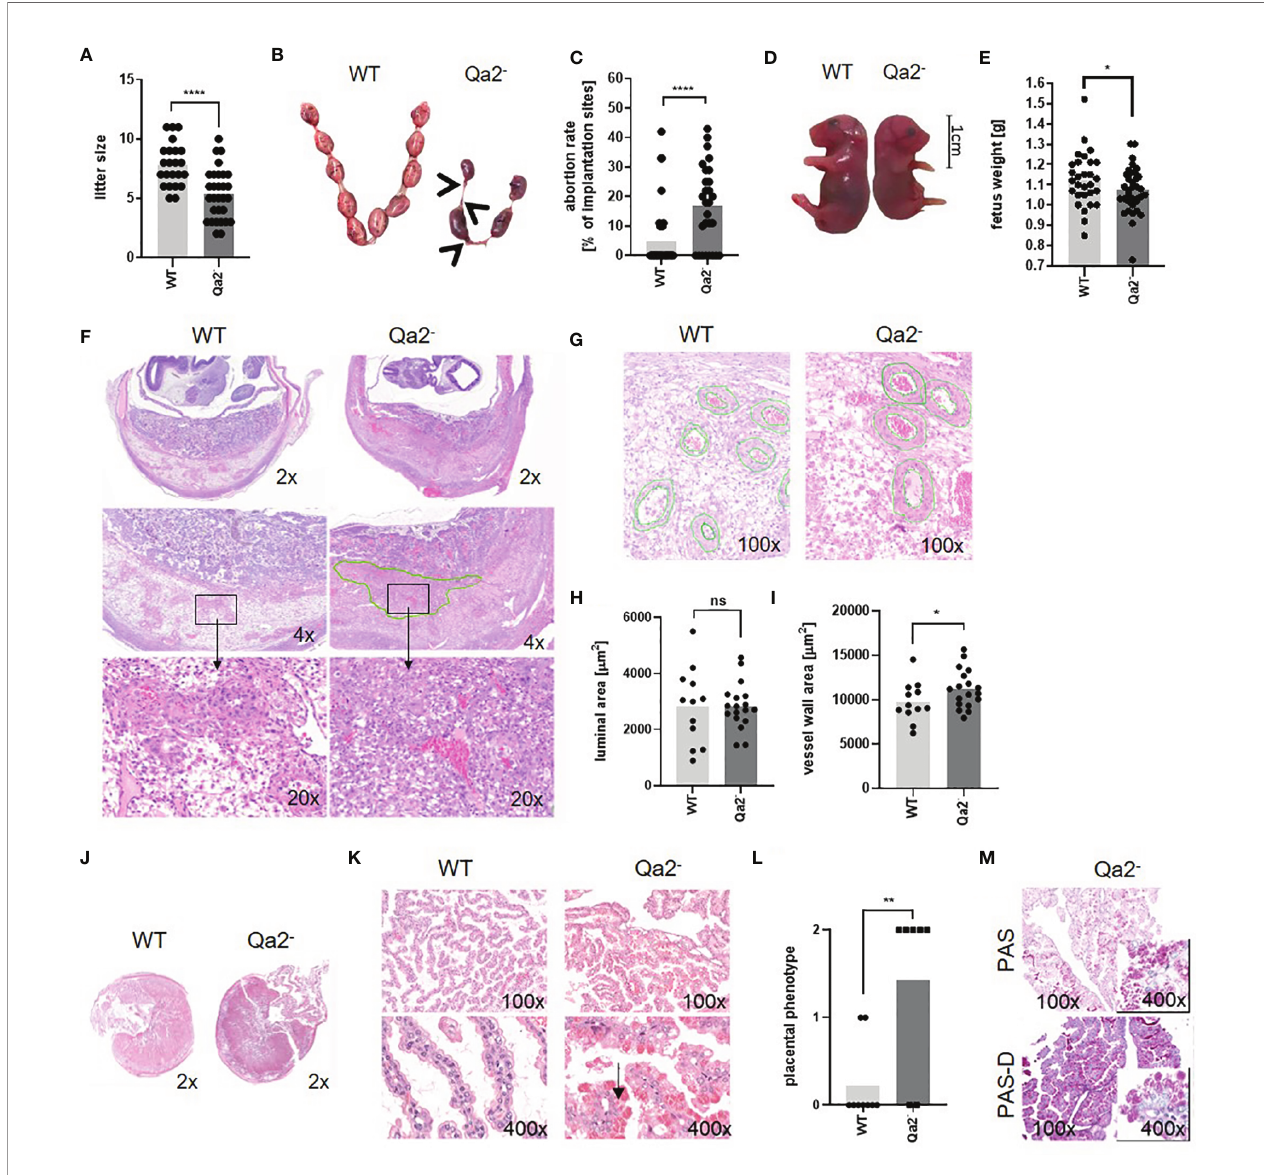
FIGURE 1 | Phenotype of Qa-2 - mice during pregnancy. Wildtype (WT) and Qa-2 de fi cient mice (Qa2 - ) were term-bred and the day when a vaginal plug was detected was de fi ned as day E0.5. Mice delivered spontaneously and litter size was determined (A) or mice were euthanized at E18.5 and uteri containing feto- placental units were removed and inspected (B – E) . Total implantation sides and resorbing units were counted and fetuses were weighed. (A) Litter size of spontaneous delivered WT (n=23) and Qa2 - mice (n=30). (B) Representative uteri containing feto placental units from WT and Qa-2 - mice at gestational day E18.5. Arrows show resorbing units. (C) Abortion rate (percentage of resorbed fetuses per litter) of WT (n=39) and Qa-2 - mice (n=28) at E18.5. (D) Representative WT and Qa-2 - fetuses at E18.5. (E) Weight of WT (n=29) and Qa-2 - fetuses (n=35) at E18.5. (F – I) Mice were euthanized at E10.5, uterine arteries were ligated and spiral arteries were analyzed. (F) Representative images of H&E stained WT and Qa-2 - uteri showing cross-section areas of placenta and decidua in different magni fi cations. The green line shows an area with unorganized trophoblast distribution within the Qa-2 - decidua. (G) Representative images of H&E stained WT and Qa-2 - uteri showing quanti fi cation of spiral artery wall and luminal area. (H) Luminal area of spiral arteries from WT (n=5) and Qa-2 - animals (n=5). (I) Vessel wall area of spiral arteries from WT and Qa-2 - animals. (J – M) Mice were euthanized at E18.5 and placentas were analyzed. (J) Representative images of H&E stained cross-section areas of WT and Qa-2 - placentas. (K) Representative images of H&E stained chorionic villi from WT and Qa-2 - placentas showing abnormal vacuoles with eosinophilic aggregates in trophoblasts of Qa-2 - animals (arrow). (L) Grade of eosinophilic aggregation in trophoblasts of WT and Qa-2 - animals. (M) Representative images of PAS and PAS-diastase stained chorionic villi from a Qa-2 - placenta showing aggregates still present in PAS-diastase staining. Each symbol represents an individual mother (A, C, L) /fetus (E) /measurement (H+I) and the mean is indicated. ****p < 0.0001; **p < 0.01; *p < 0.05; ns, not signi fi cant. Mann-Whitney test (A, C, L) or unpaired t-test (E, H, I)